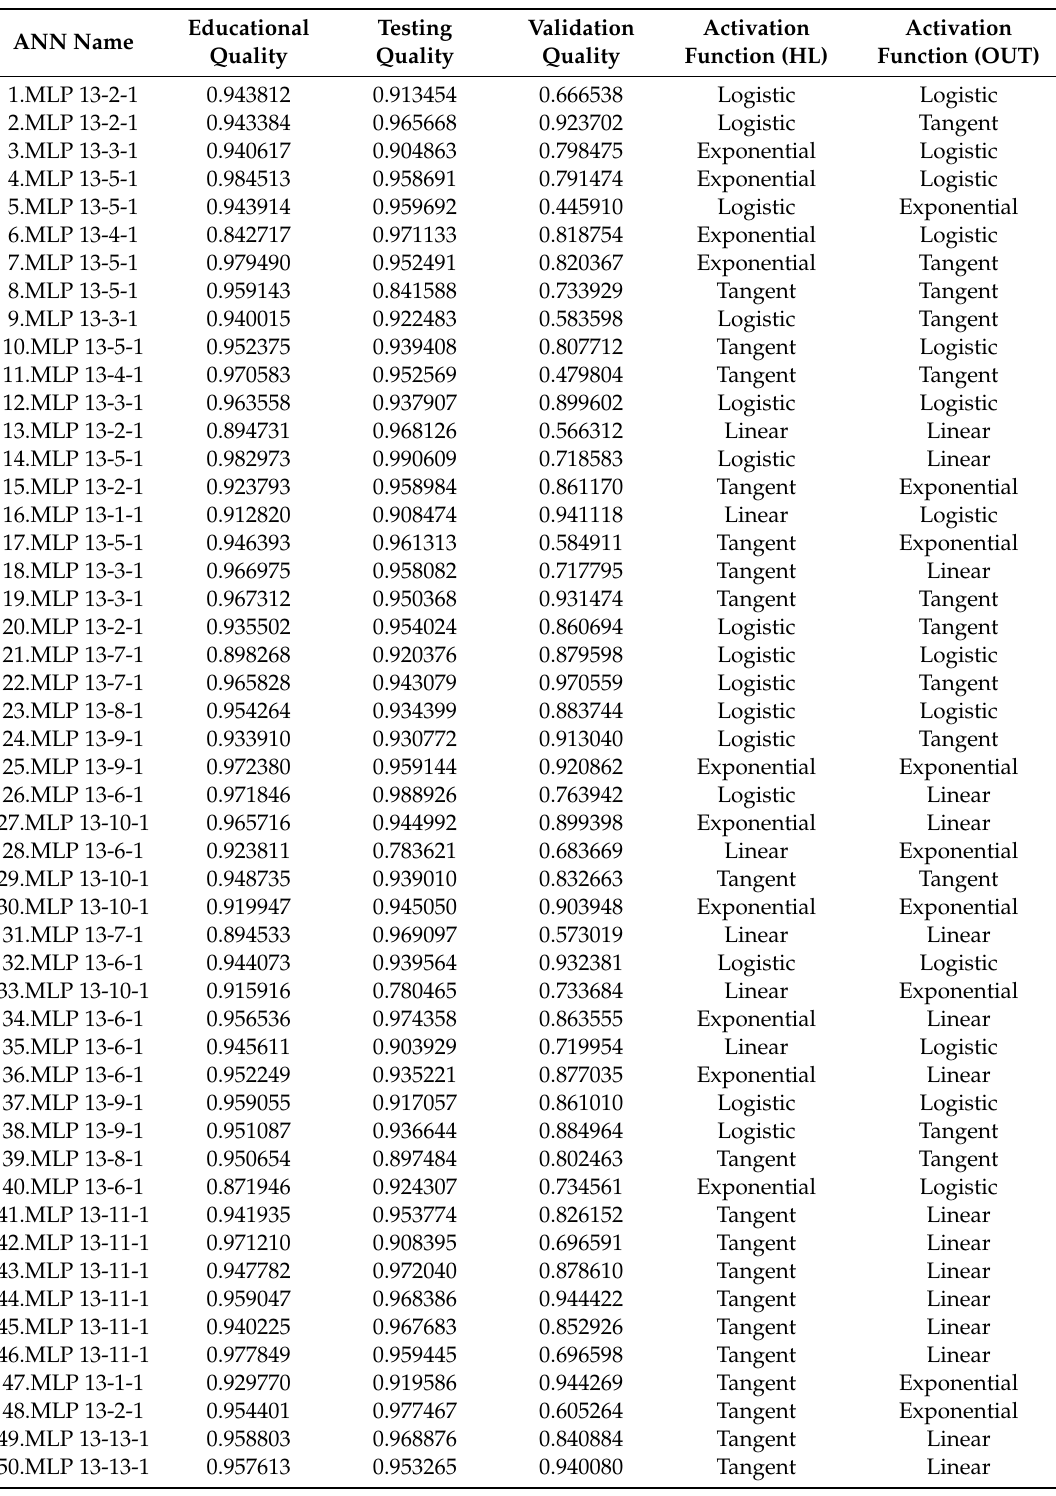
Table 11. Structure of MLP networks ( VB c